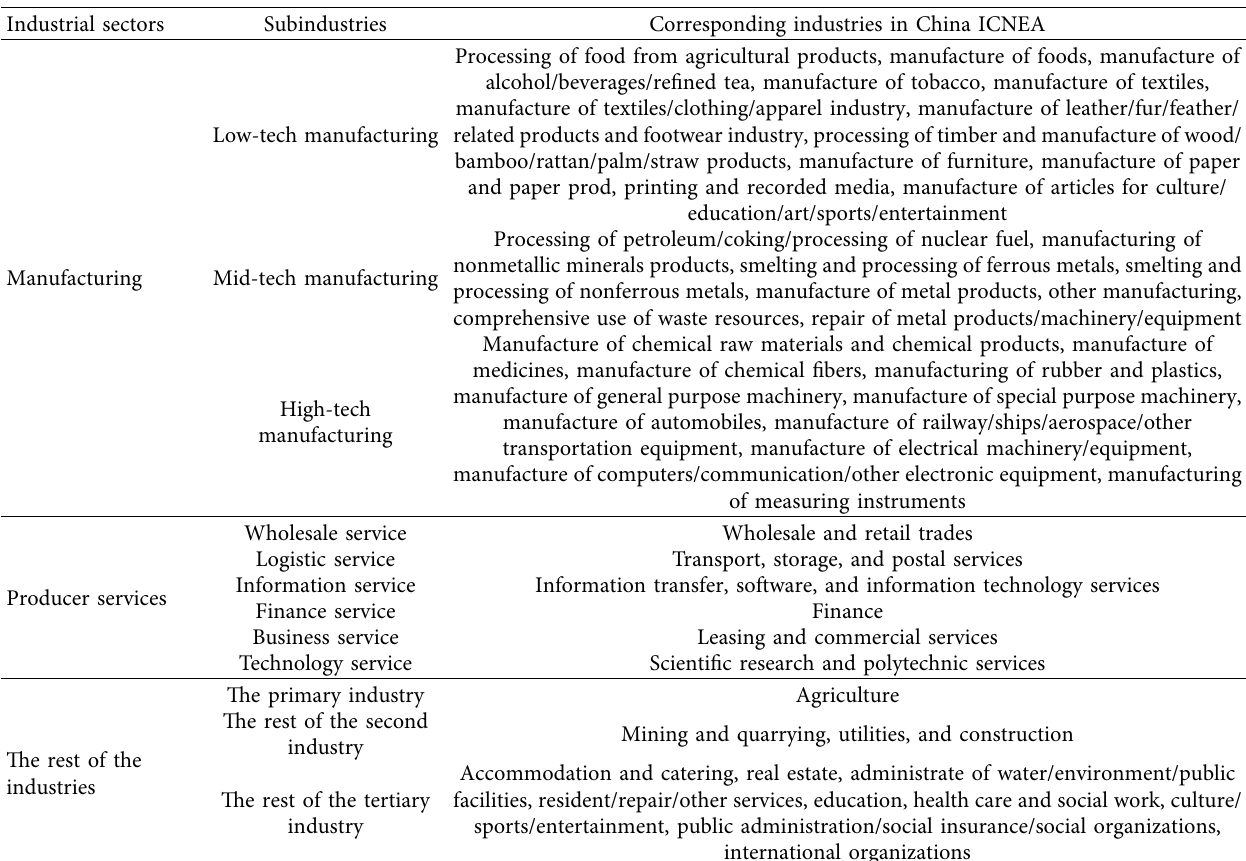
Table 7: The classification of the entire economic system of